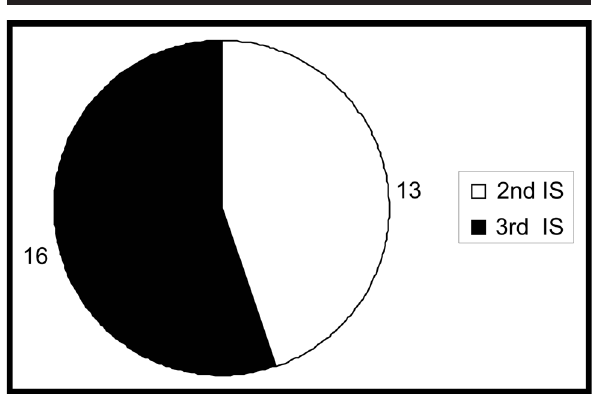
FIGURE 3 - Total Lymph node count in the 2nd and 3rd intercostal